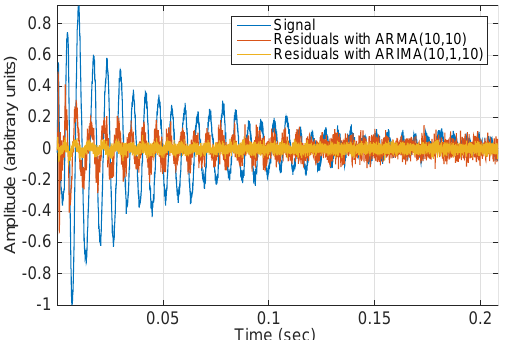
Figure 2. Example of how ARIMA(10,1,10) achieves better modeling (smaller residuals) than ARMA(10,10) in signals having a trend similar to that of an UNDEX